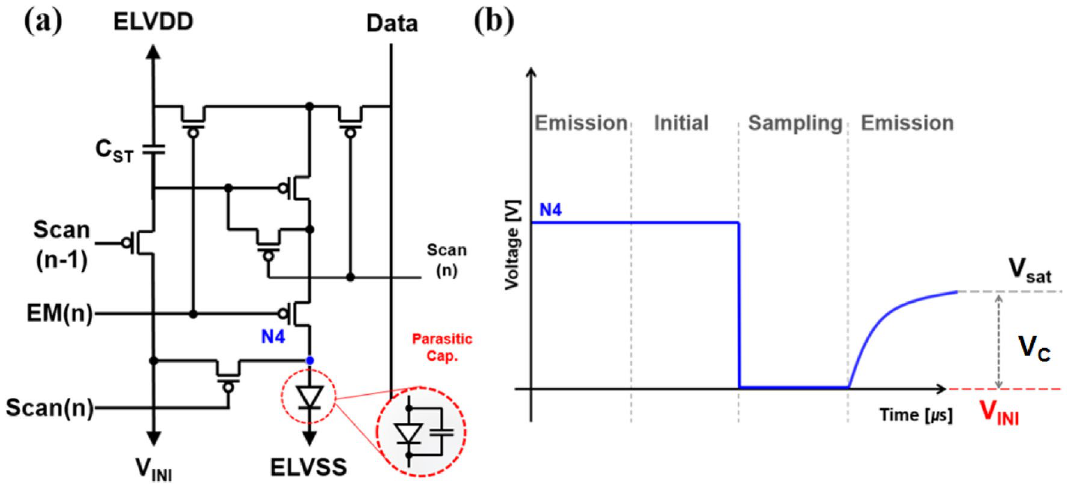
Figure 4. ( a ) Schematic of a 7T1C pixel circuit. ( b ) A schematic diagram for the OLED anode node voltage described by the compensation